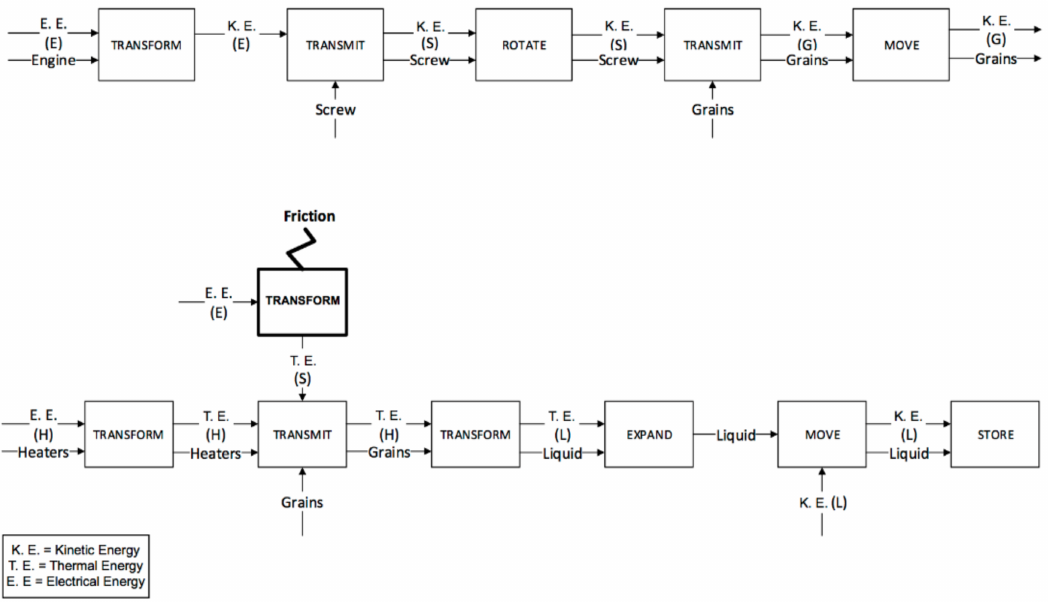
Figure 7. Plastication phase for the IM machine.